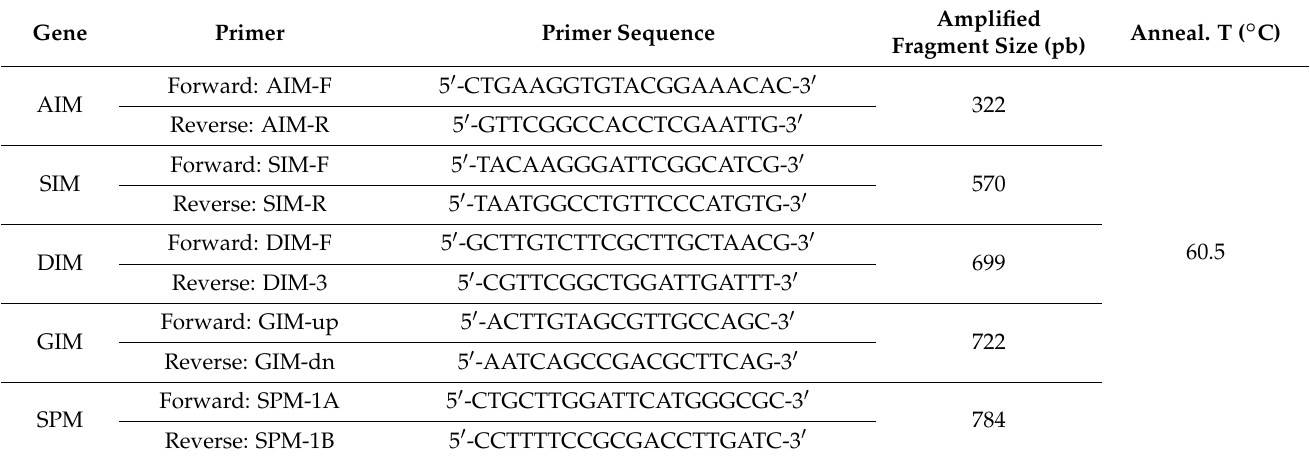
Table 3. The primers used for the amplification of less common B carbapenemases (AIM, SIM, DIM, GIM,